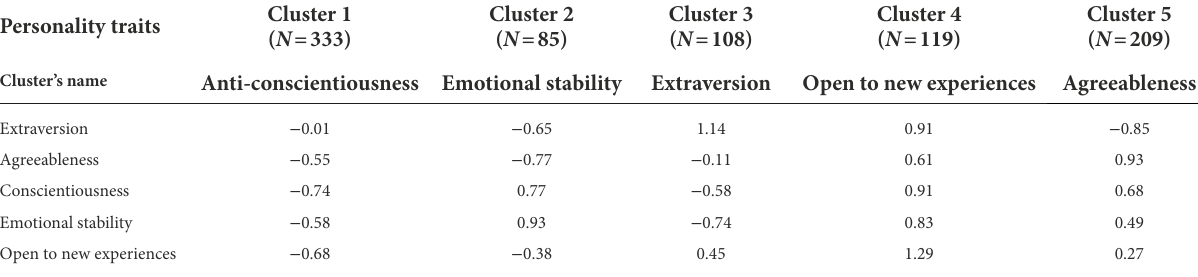
TABLE 5 Cluster analysis